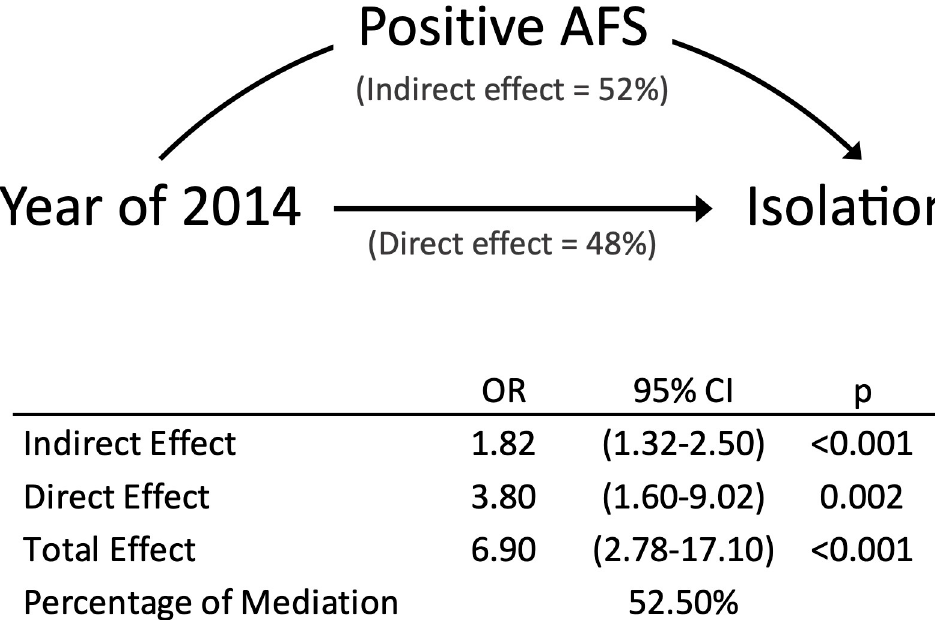
Fig 2. Causal mediation analyses of the effect attributable to switching from conventional to fluorescence microscopy. Abbreviations: Year of 2014, 2014 vs. 2001; Positive AFS, positive acid-fast smear results; Isolation, respiratory isolation within 7 days.